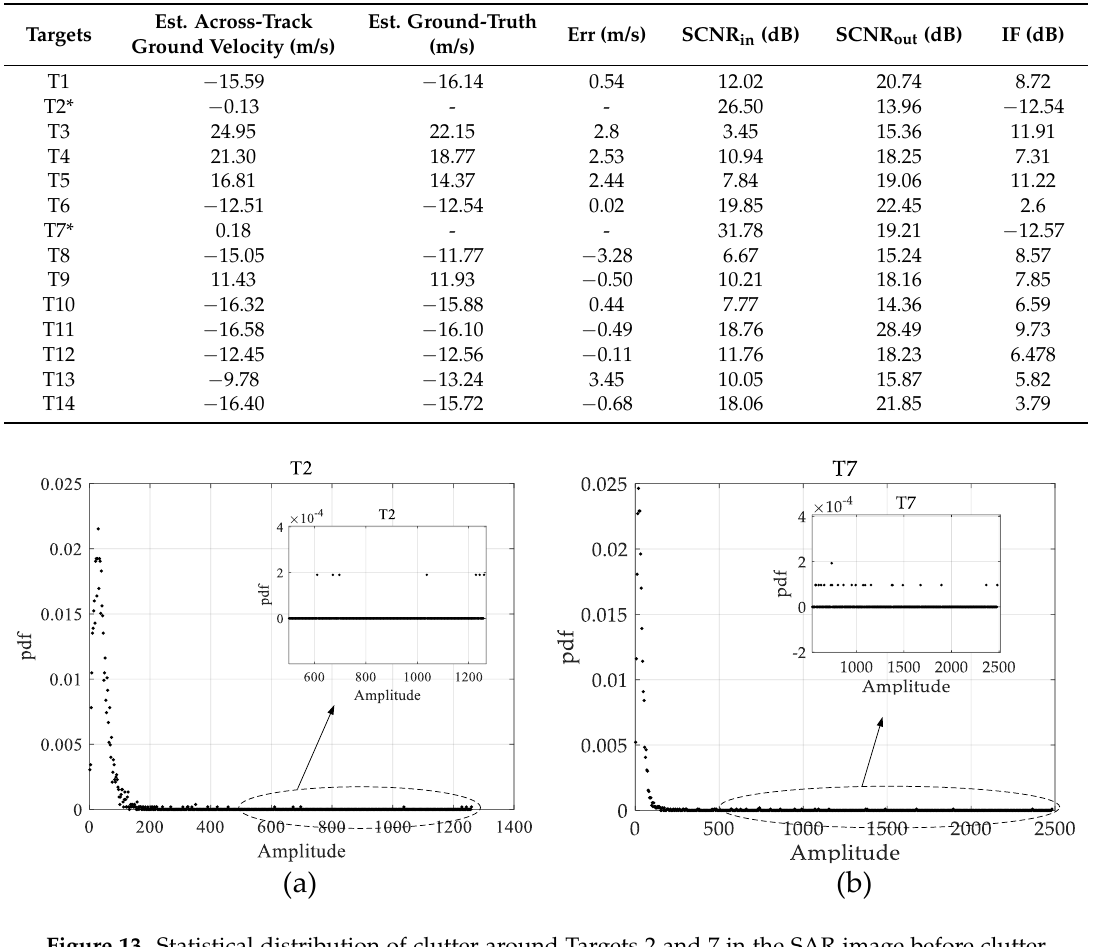
Figure 13. Statistical distribution of clutter around Targets 2 and 7 in the SAR image before clutter cancellation: ( a ) clutter distribution around Target 2; and ( b ) clutter distribution around Target 7.